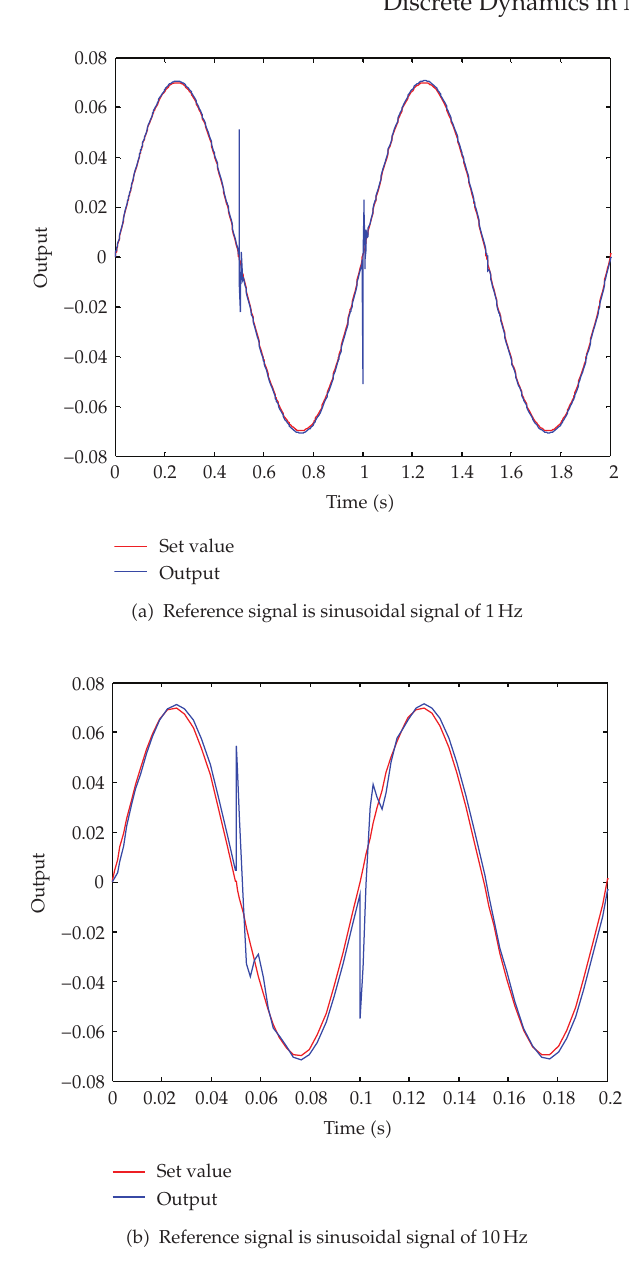
Figure 13: Output curves of di ff erent